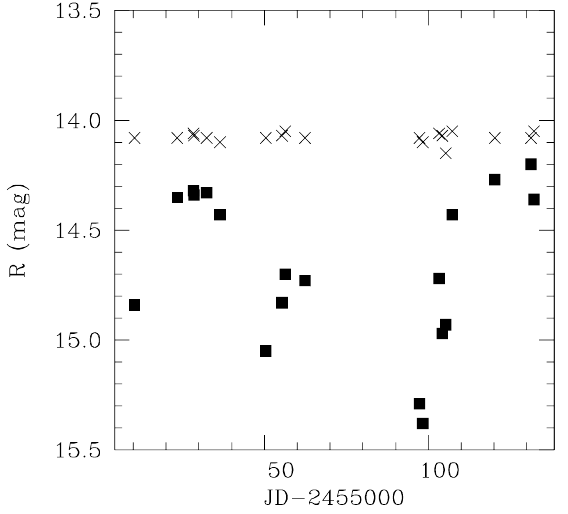
Figure 3: The light curve of V22822 Sgr from CCD images of the Cornero Observatory. Crosses are a com- parison star, filled squares are the variable.